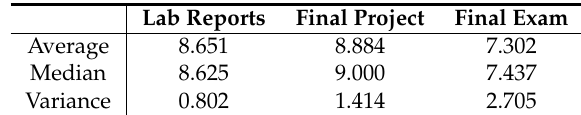
Table 4. Average, median and variance of the grades obtained by all the students that took the